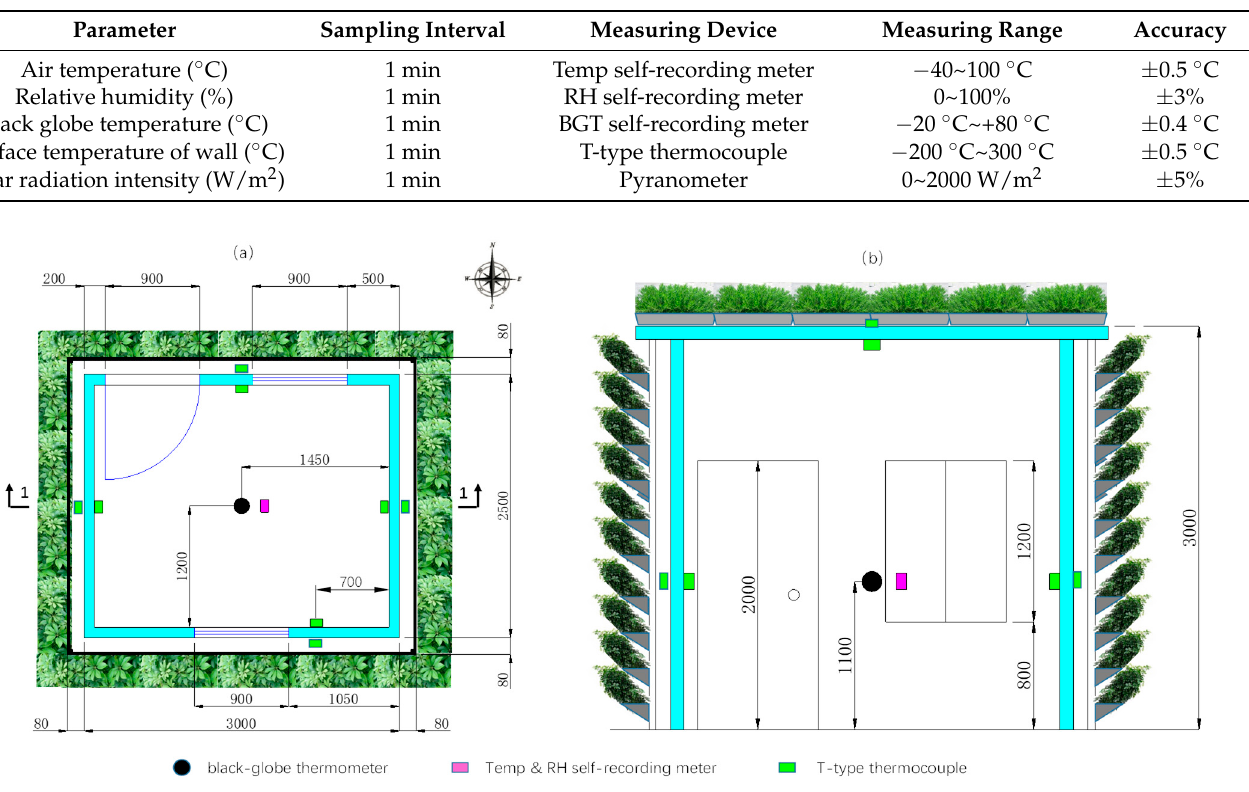
Figure 2. Installation locations of sensors: ( a ) plan and ( b ) cross-section 1-1 (the unit of dimensions is